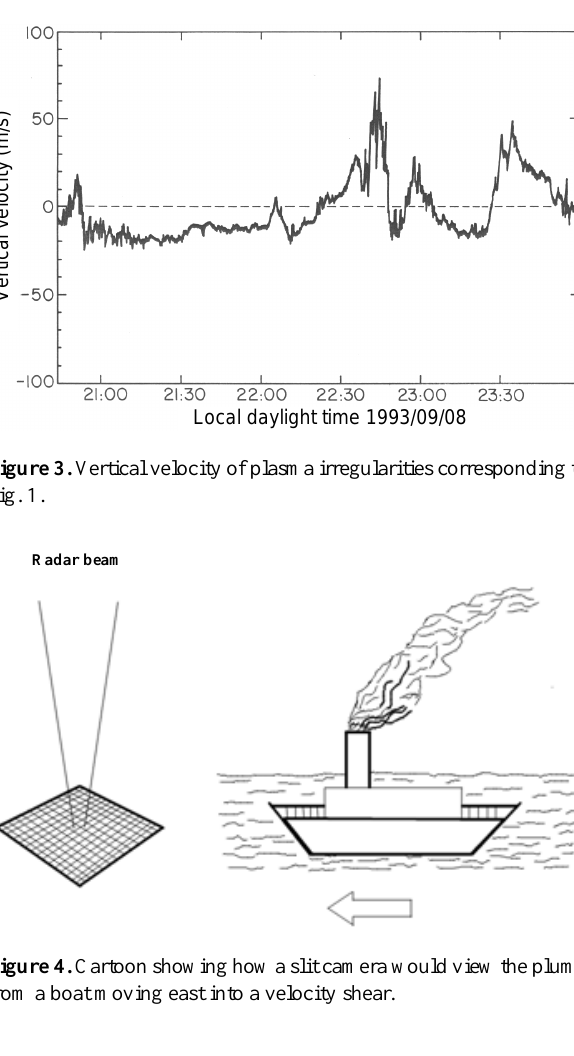
Figure 2. The same as Fig. 1 but on 9 September 1993. This event occurred during low magnetic activity (Kp = 2).